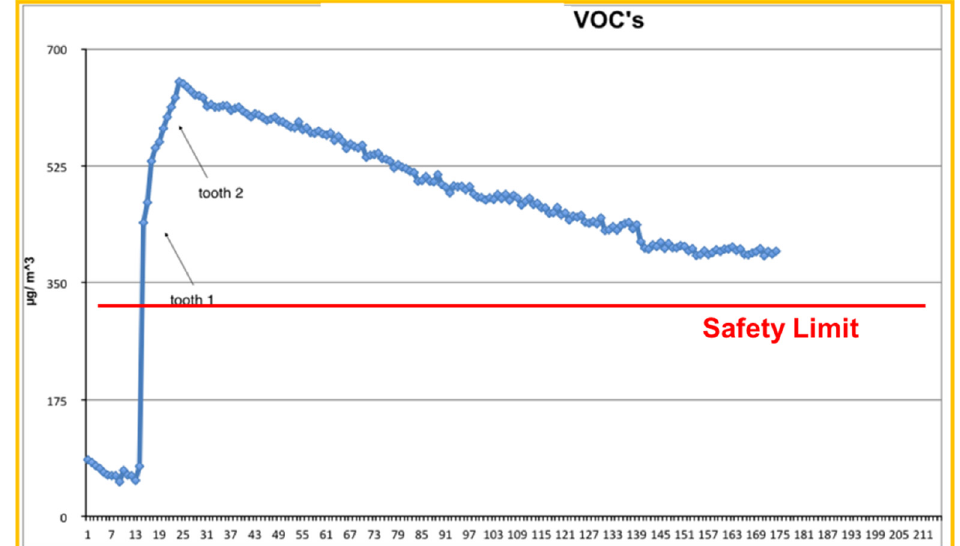
Figure 2. Presentation of TVOCs’ recordings (over a 3-h span), on D2 for a period of 20 min working with Er:YAG Laser usage. The arrows indicate the completion of working time for each tooth.